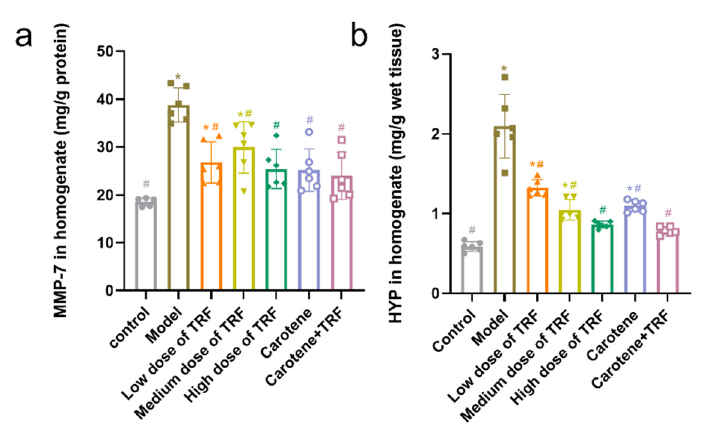
Figure 5. Effects of TRF and carotene on HYP and MMP-7 levels in lung tissue: a, Effects of TRF and caroteneon on MMP-7 in the lung tissues of BLM-induced lung fibrosis, n = 6; b, Effects of TRF and caroteneon on HYP in the lung tissues of BLM-induced lung fibrosis, n = 6; Note: compared with CON group, # represents p < 0.05; compared with MOD group, * represents p <